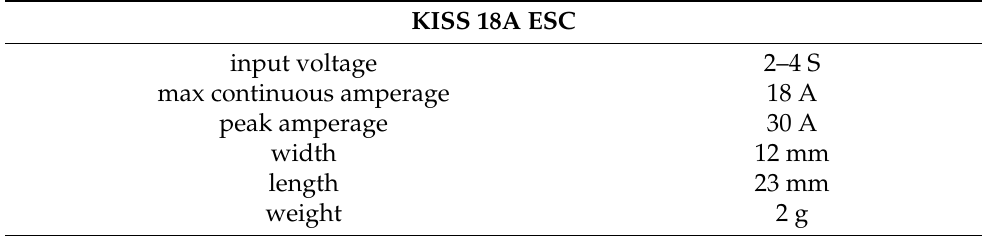
Table 4. Design of a modular drone: datasheet of the KISS 18A